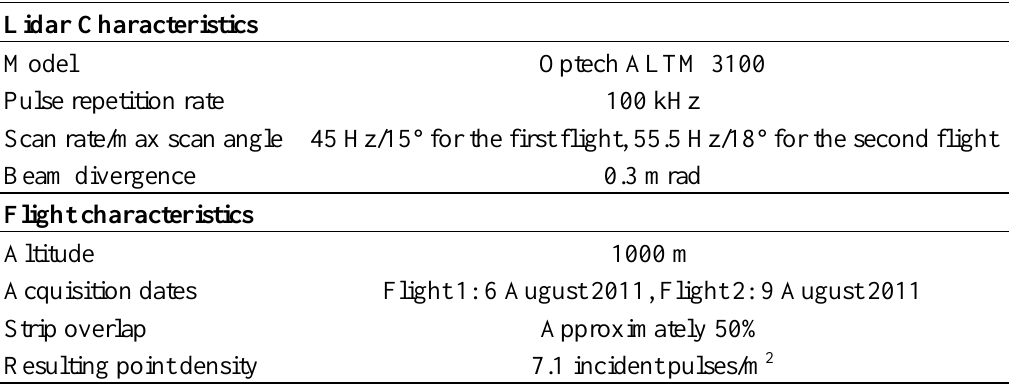
Table 3. Lidar flight and data